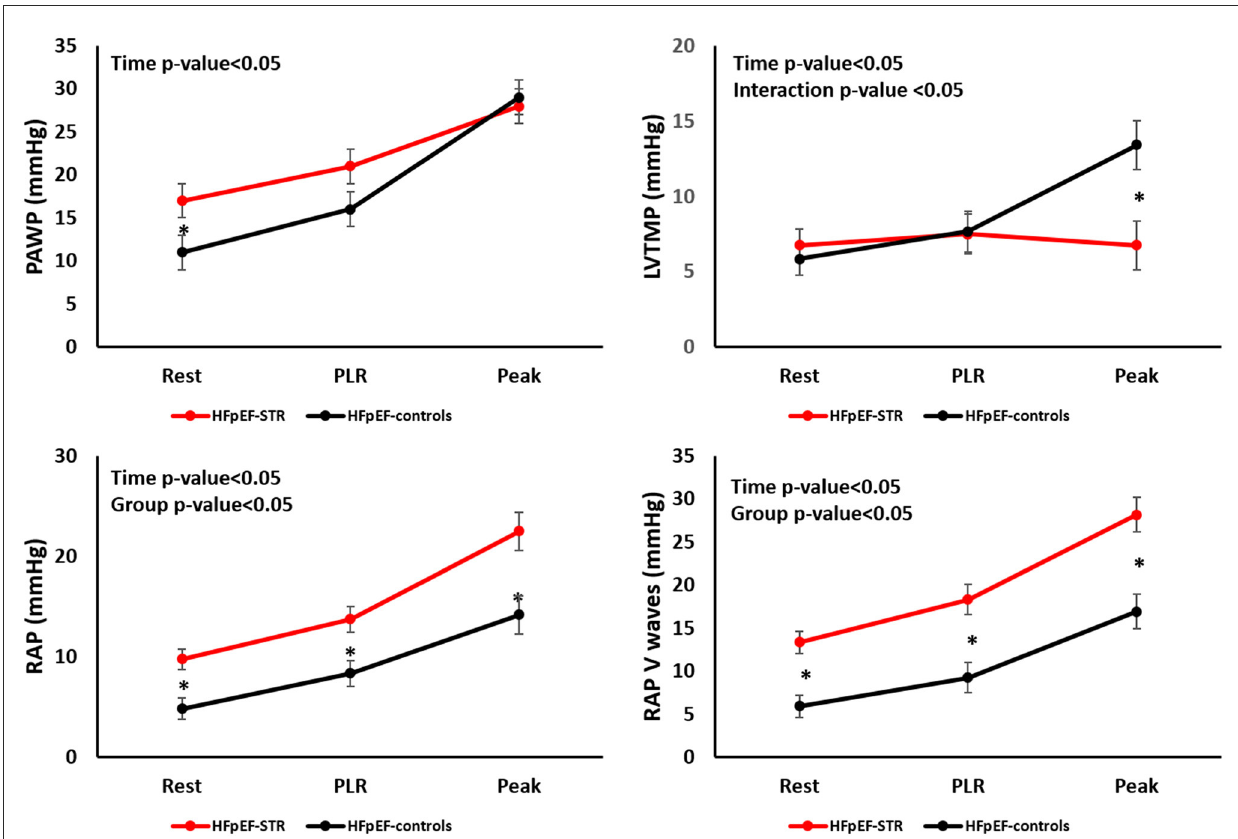
FIGURE2 Evolution of left and right heart hemodynamics during exercise in our patients’ population. HFpEF, heart failure with preserved ejection fraction; LVTMP, left ventricular transmural pressure; PAWP, pulmonary artery wedge pressure; PLR, passive leg raising; RAP, right atrial pressure; STR, secondary tricuspid regurgitation. * P <